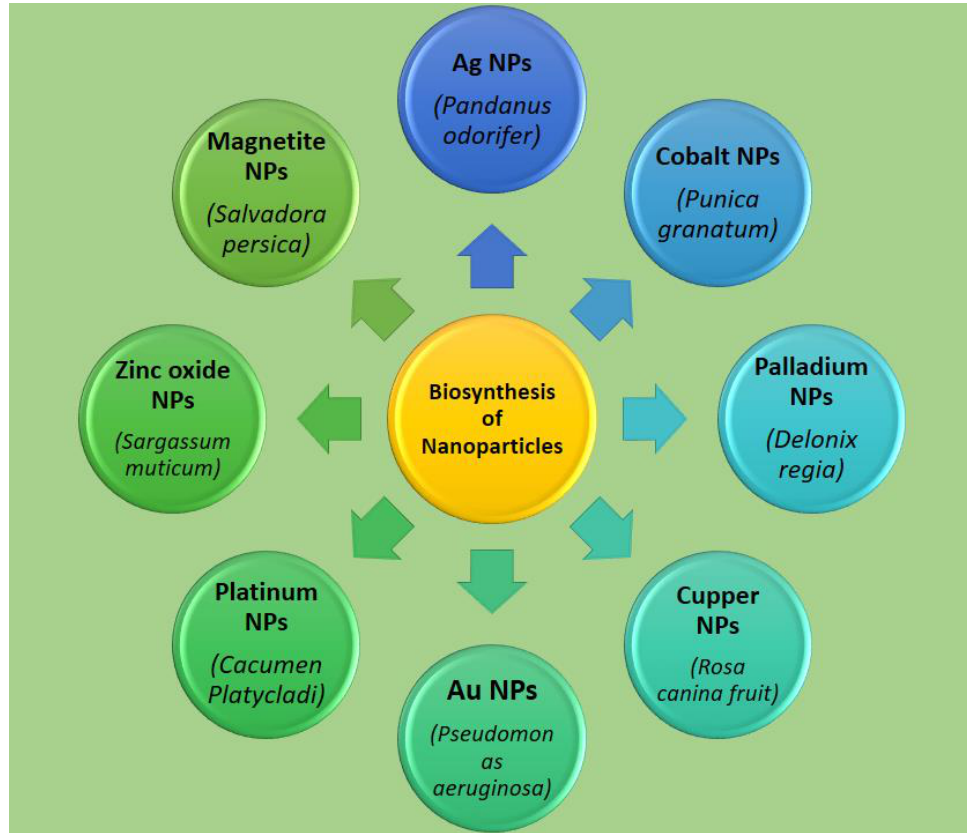
Figure 2. Various nanoparticles derived from plant resources, extract presented in the